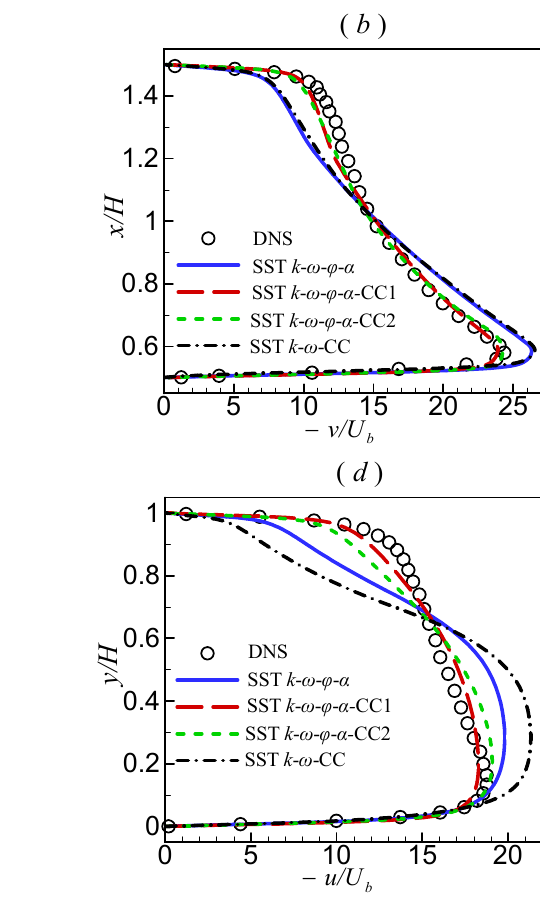
6 of 15 Figure 2. The velocity magnitude contours predicted by different turbulence models for the 2D infinite serpentine passage flow.